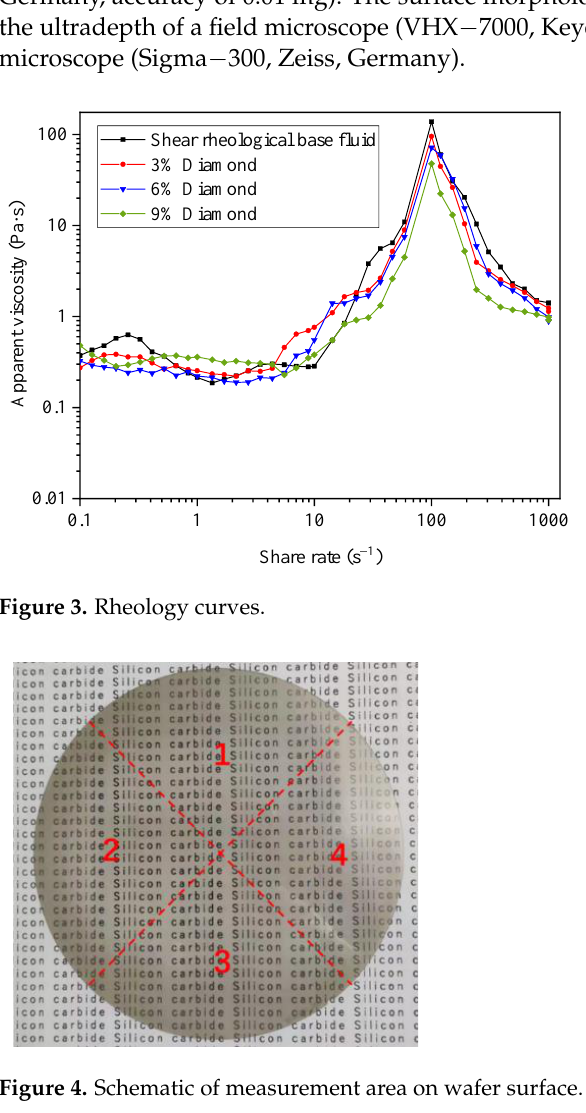
Figure 4. Schematic of measurement area on wafer surface.